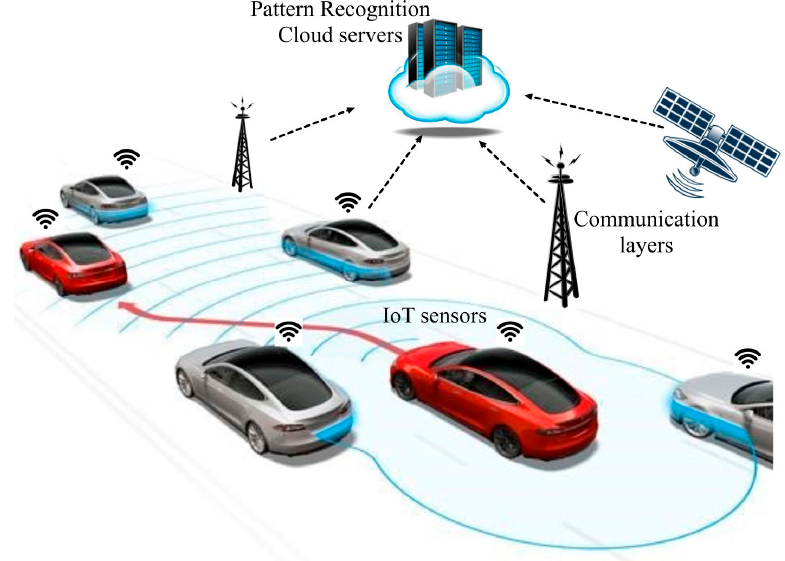
Figure 1. Conceptual vehicle-road-environment interactions.